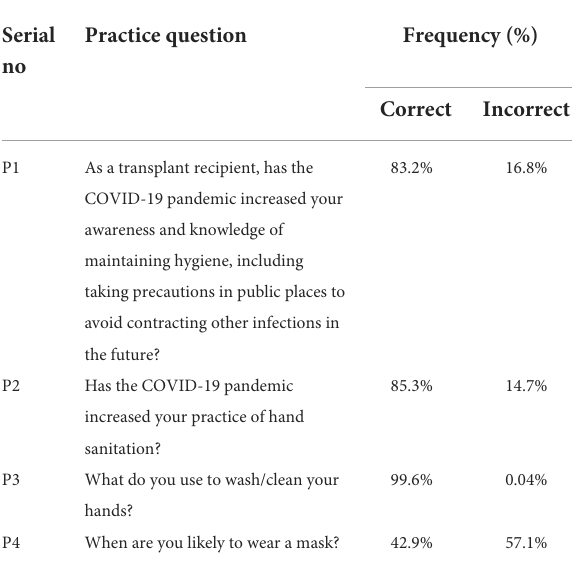
TABLE 4 Practice responses toward COVID-19 among solid organ transplant recipients ( N =